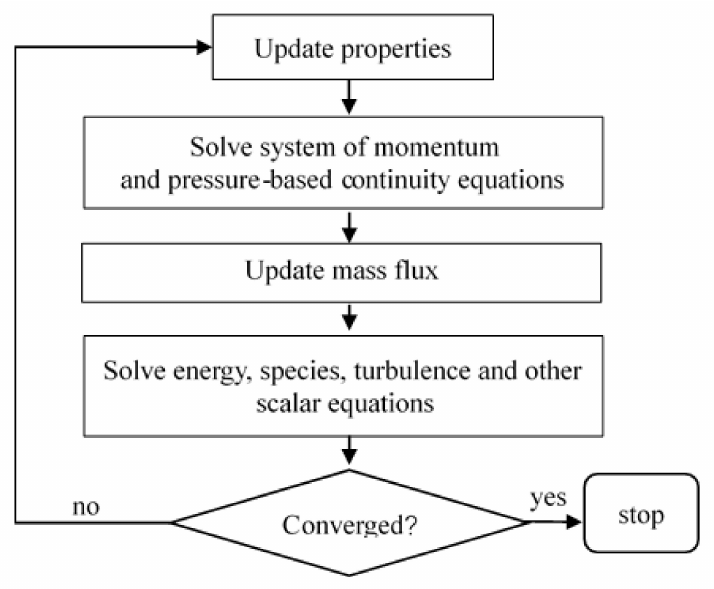
Figure 2. Pressure-based